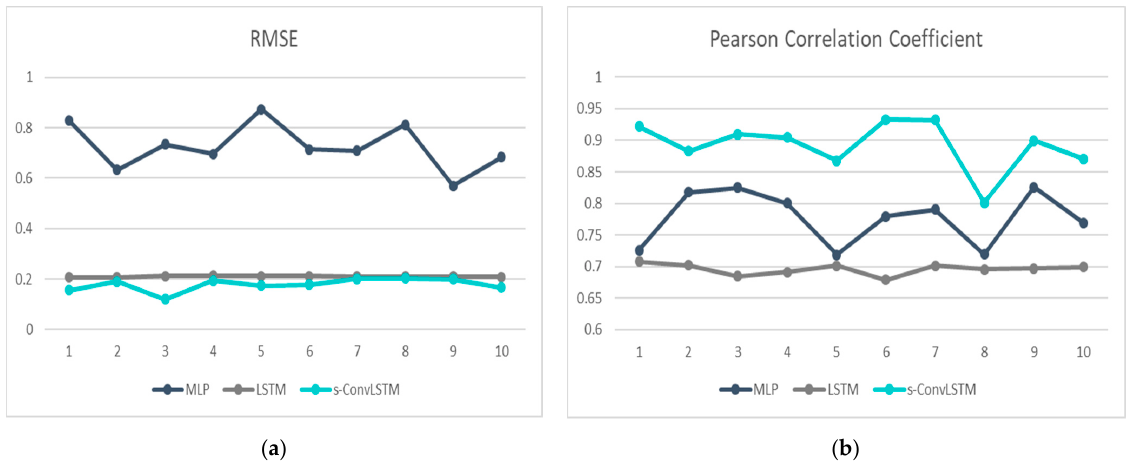
Figure 11. Graph of experiment: ( a ) RMSE of prediction models and ( b ) Pearson’s correlation coefficient.